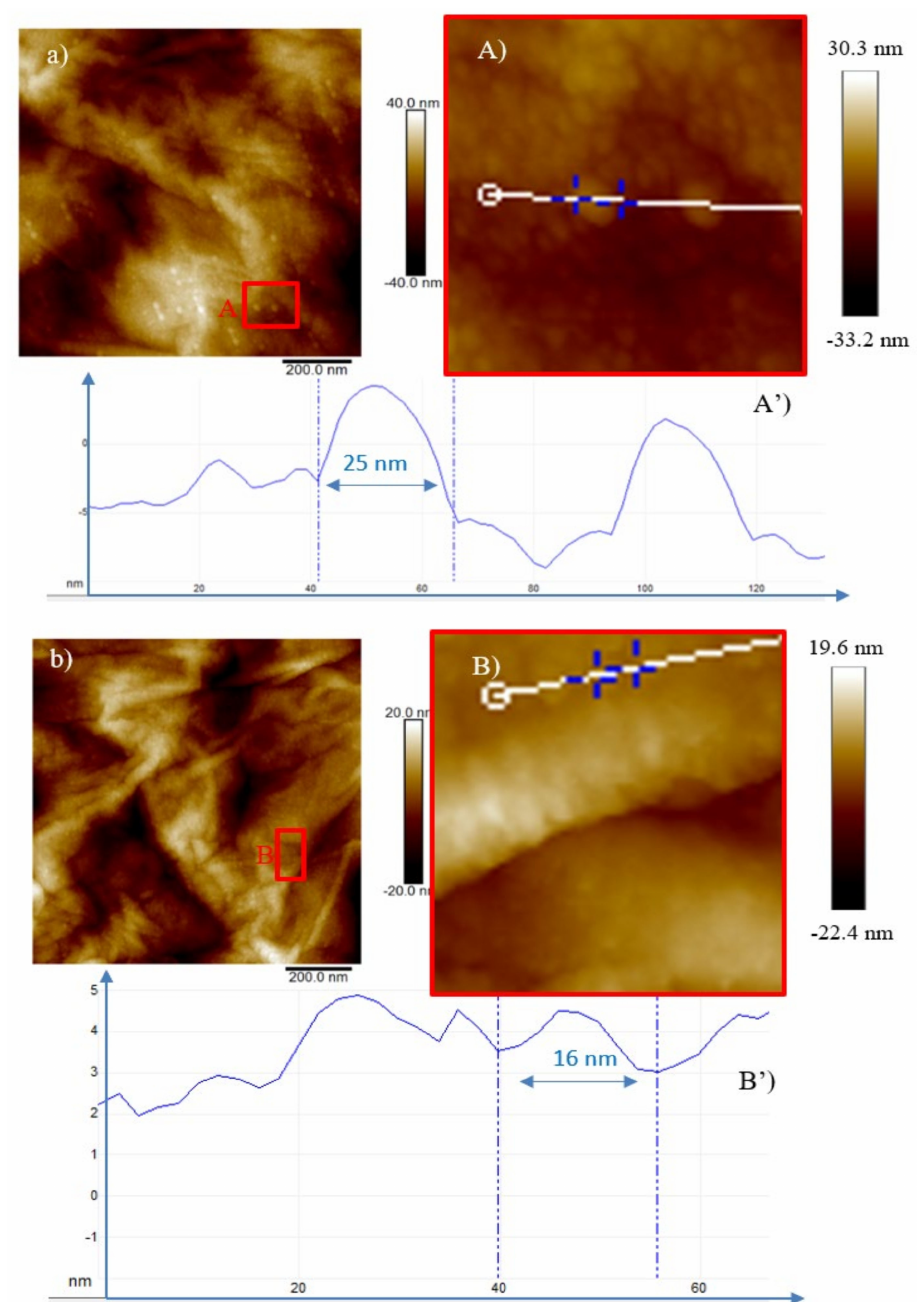
Figure 6. 2D AFM images of GO irradiated by the 3 MeV H + ions at the 5 × 10 11 ions/cm 2 fluence ( a ), magnified area of the red square ( A ) and profile of the selected structure ( A’ ) and at the 5 × 10 12 ions/cm 2 fluence ( b ), magnified area of the red square ( B ) and profile of the selected structure ( B’